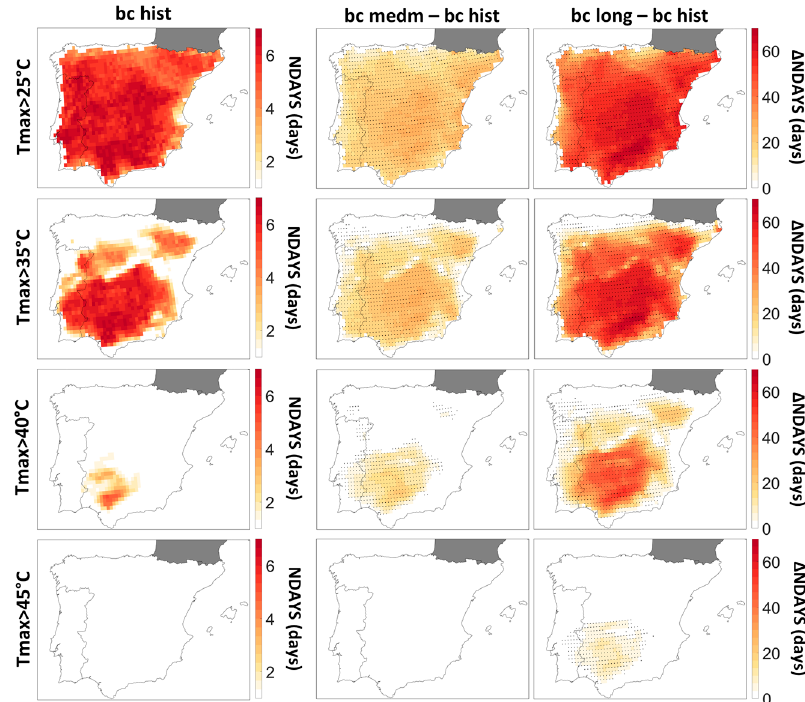
Figure 12. Mean number of heat wave days per year (NDAYS, days) due to the combination of heat waves and maximum temperature thresholds—25 °C (first row), 35 °C (second row), 40 °C (third row), and 45 °C (forth row)—for the historical period (bc hist, first column). Differences between the medium- and long-term future and the historical period [bc medm—bc hist (second column) and bc long—bc hist (third column), respectively]. Statistically significant differences (Student’s t -test) at the 5% significance level are represented by black dots.